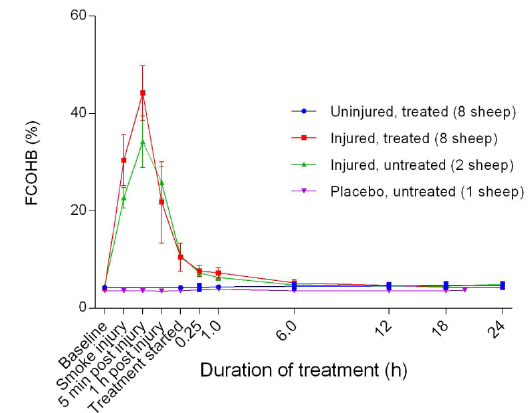
Figure 10. Fraction of carboxyhaemoglobin (FCOHb) (Mean ± SD) in smoke and non-smoke injured sheep that received extracorporeal life support as compared to that in untreated